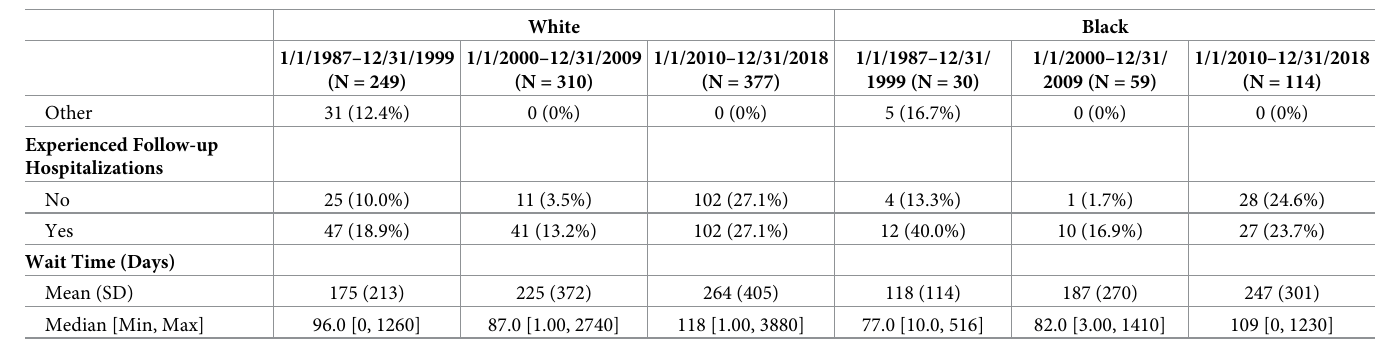
Table 3. Hazard ratios and 95% confidence intervals comparing mortality rates for black post-transplant stroke survivors to mortality rates for white post-trans- plant stroke survivors according to era, Scientific Registry of Transplant Recipients (SRTR), January 1, 1987 To December 31, 2018.